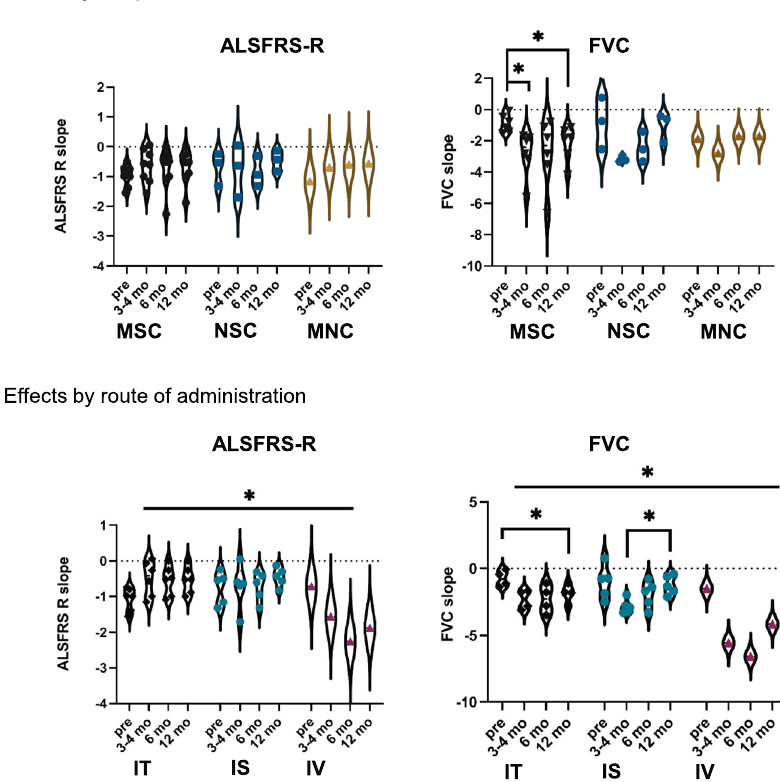
Fig. 4 Effects of cell type and delivery on outcomes. Violin plots showing the effect of a the cell product and b the administration route, on the differences between ALSFRS-R and FVC slopes calculated for the lead-in period (pre) and the follow-up time points, as indicated. Points represent individual studies. Discontinued lines represent the mean value. Two-way ANOVA with post-hoc Tukey ’ s test, * P ≤ 0.05. IS intraspinal, IT intrathecal, IV intravascular, mo